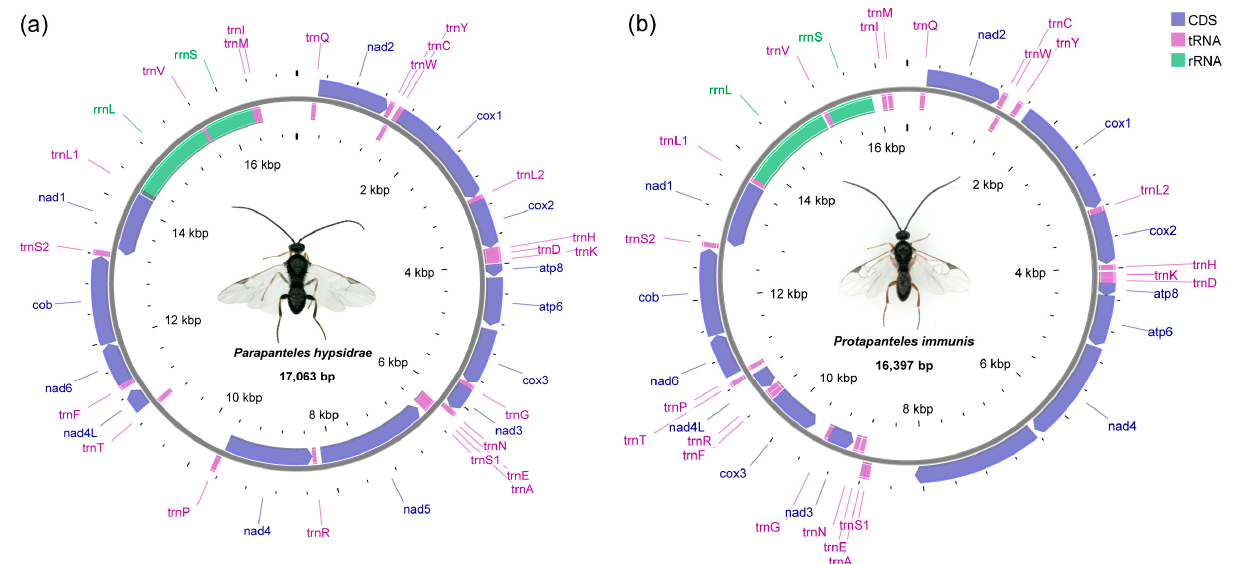
Figure 1. Maps of the mitochondrial genomes of Pa. hypsidrae ( a ), and Pr. immunis ( b ). The circle shows the gene map (PCGs, rRNAs, and tRNAs). The genes shown outside the map are encoded on the majority strand (J strand), while the genes represented within the map are encoded on the minority strand (N